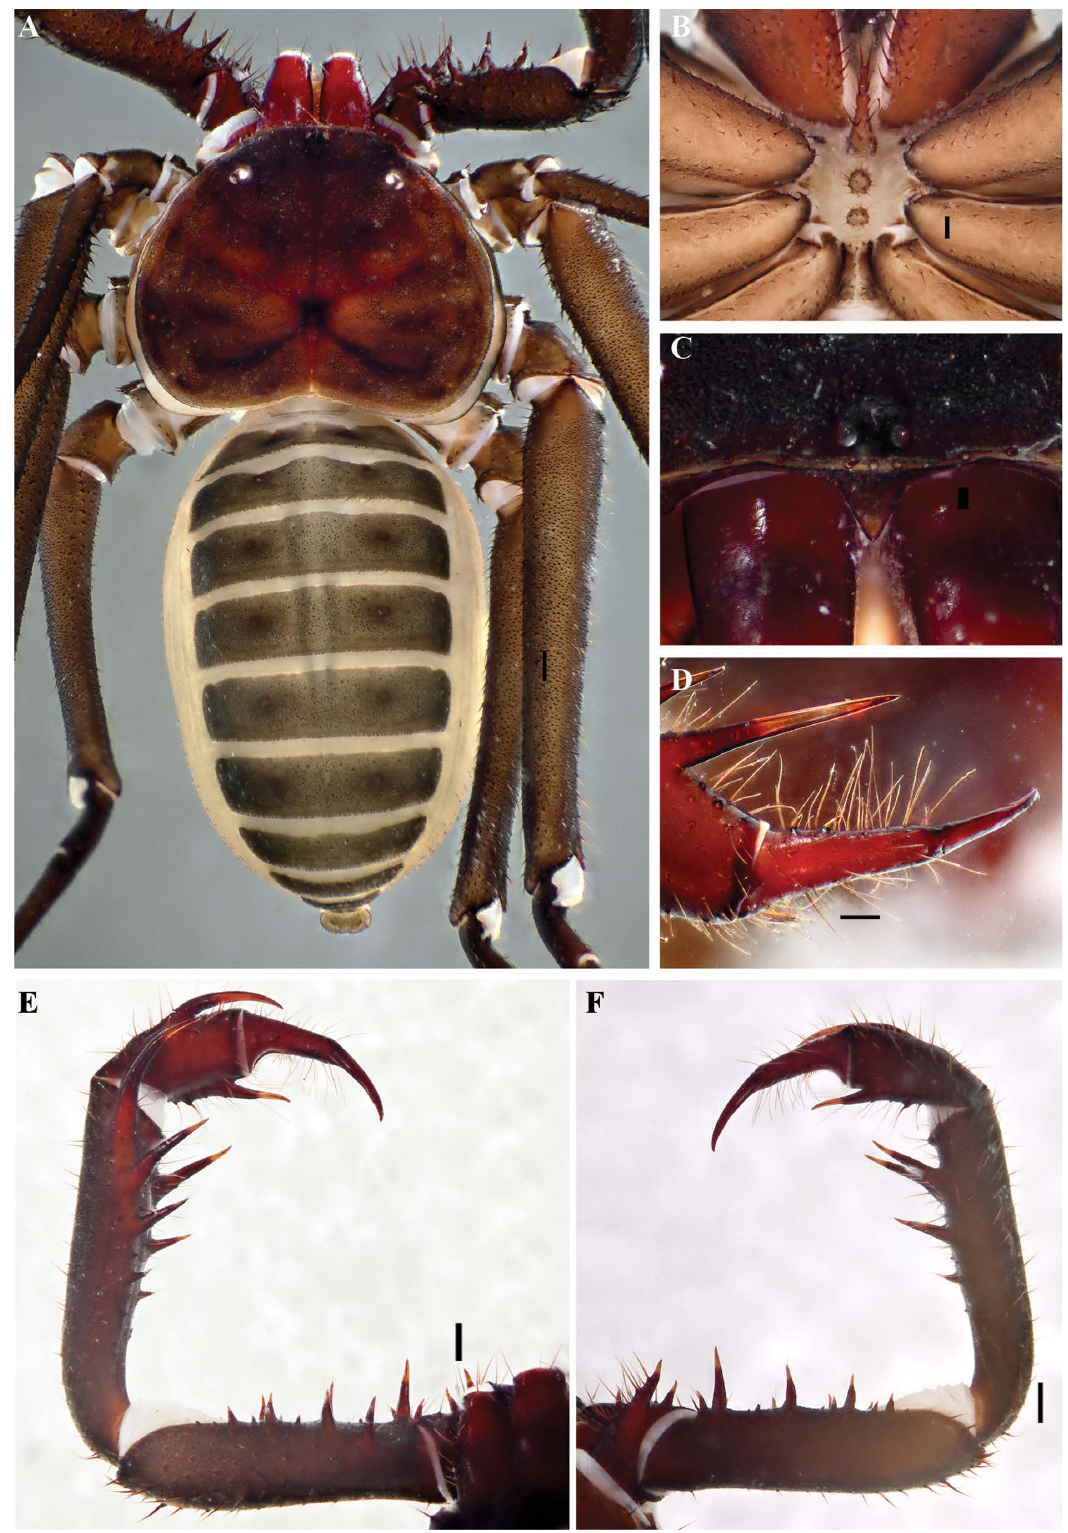
Fig. 66. Charinus imperialis sp. nov. (MNRJ 9358), general morphology. A . Habitus, dorsal view. B . Sternum, ventral view. C . Frontal process. D . Pedipalp tarsus, frontal view. E . Pedipalp, dorsal view. F . Pedipalp, ventral view. Scale bars: A, E–F = 1 mm; B–D =0.5